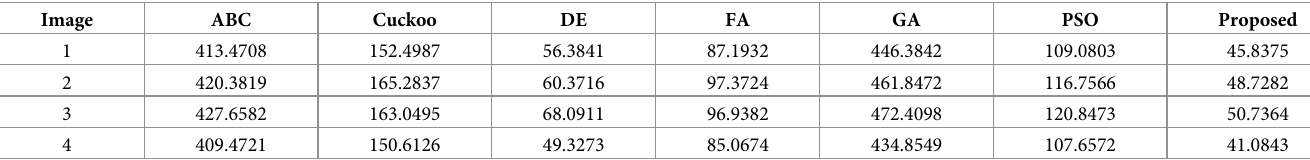
Table 9. The execution time performance (in s) evaluation of various image contrast enhancement approaches. Image